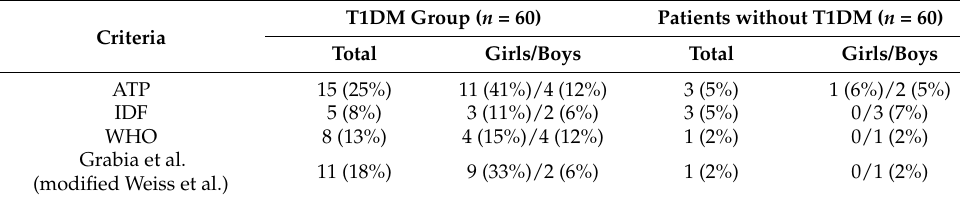
Table 3. Prevalence of metabolic syndrome, based on various criteria.